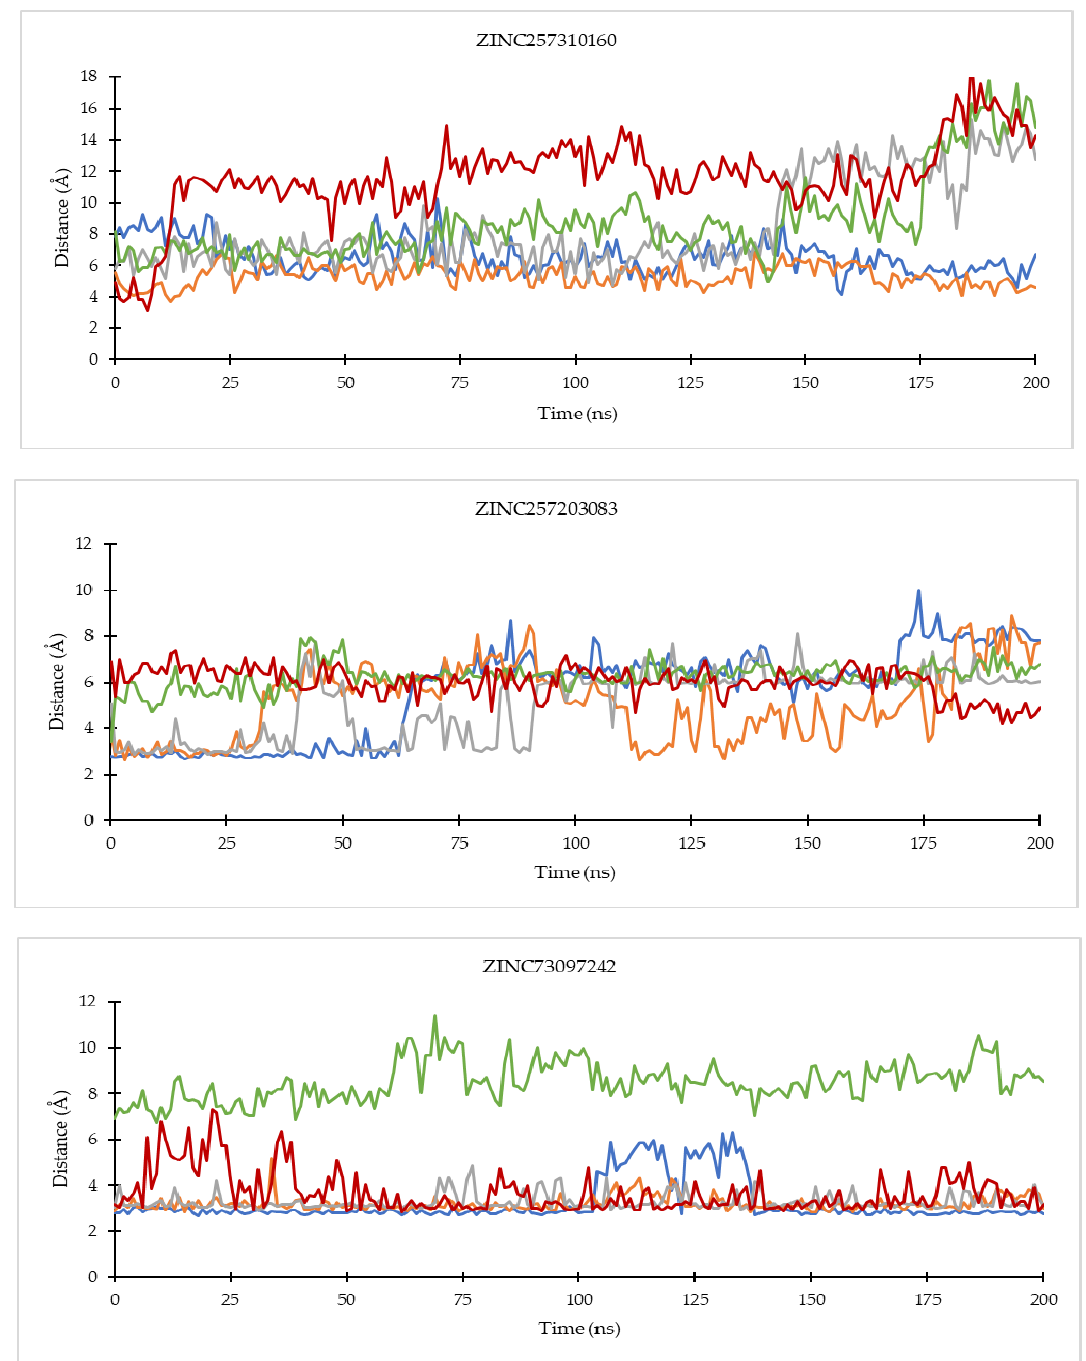
Figure 8. The evolution of the mean ligand–CDK4 residue distances of two replicas throughout the simulations. Color code: Blue: Val96; Orange: His95; Grey: Lys35; Green: Asp158; Red: Asp99.